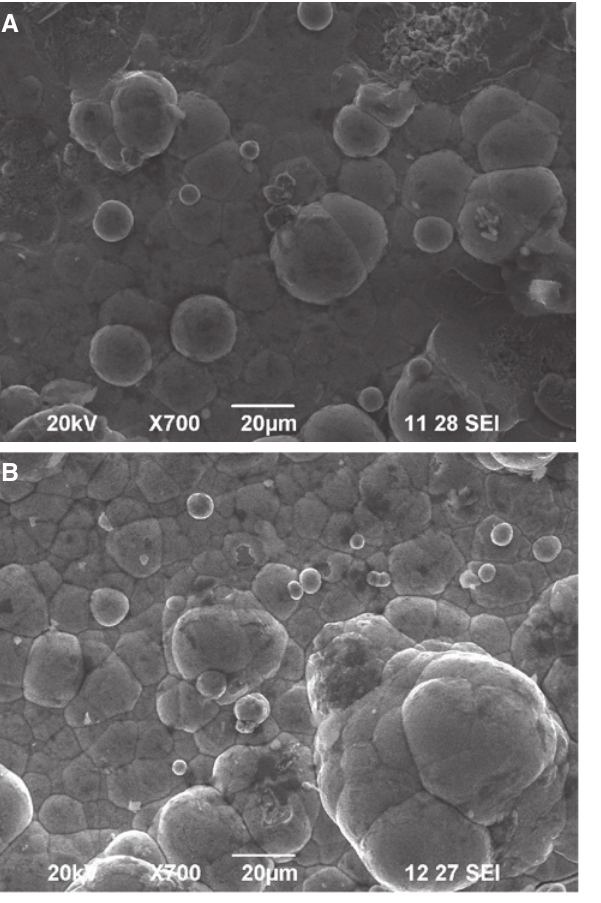
Figure 5 (A) SEM image of the Ni-P-TiO treated at 350 ° C. (B) SEM image of the Ni-P-TiO coating heat treated at 350 ° C.